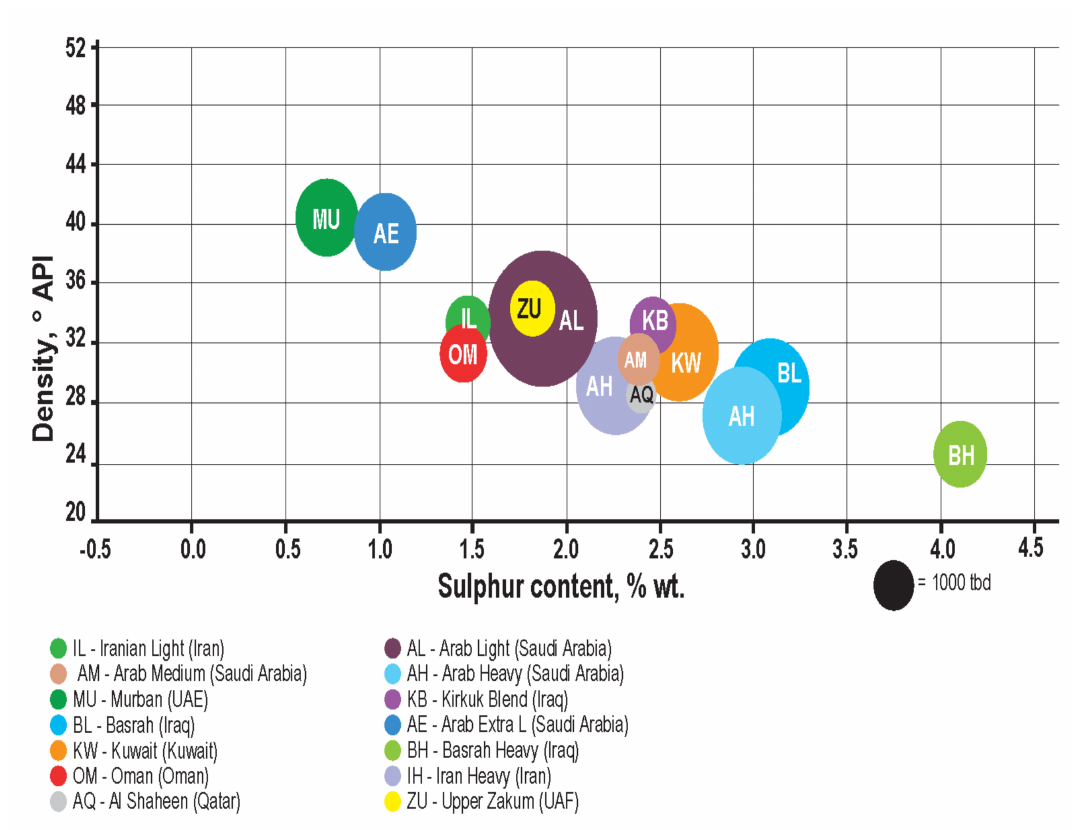
Figure 16. Quantity and quality of Middle East oil